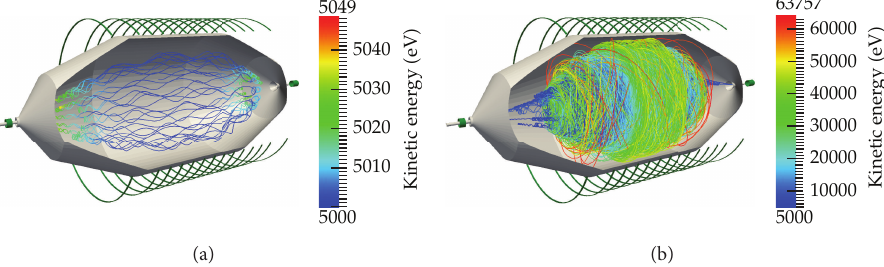
Figure 25: (a) shows the stable storage condition without external RF field, where the electron trajectory is a superposition of a fast cyclotron motion, axial oscillation, and much slower magnetron drift. (b) shows an electron trajectory in presence of an RF field with a frequency which is tuned to the cyclotron frequency of the electron in the central part of the spectrometer. The stored electron is stochastically heated up every time it passes the resonance region. After less than 5 ms its cyclotron radius is so large that the electron hits the wall and is absorbed